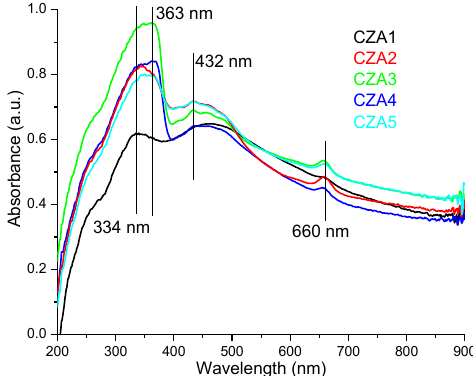
Figure 5. The UV-Vis spectra for CZA1–CZA5 films.